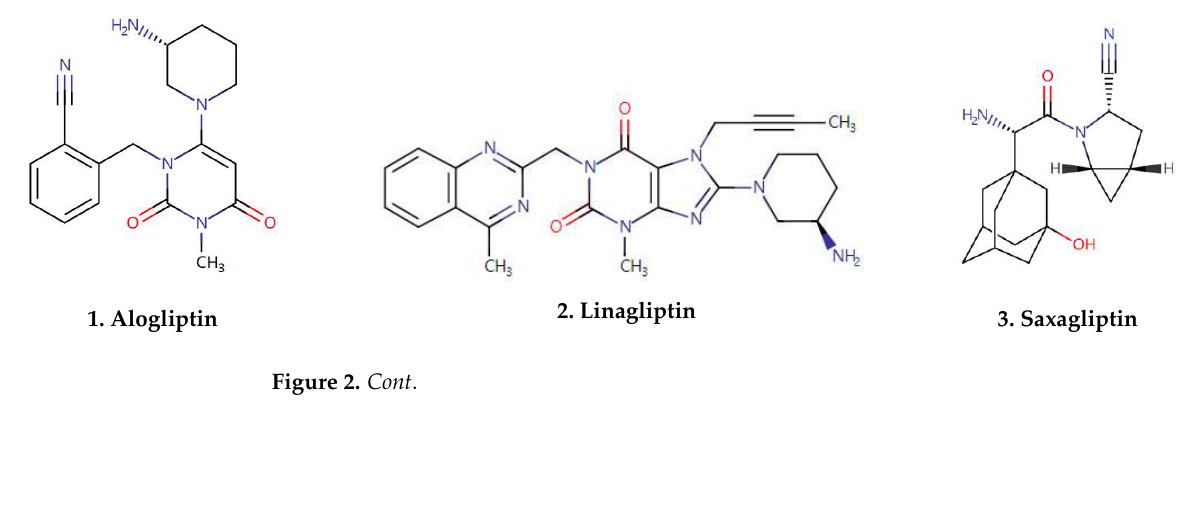
Figure 1. The effect of CD26 inhibitors performed therapeutically in different immune-mediated diseases through a biased Th1 to Th2 cytokine profile. The inhibition of CD26 breaks Th1-cell- mediated immune stimulation, as well as activating the Th2-cell-mediated immune suppression.